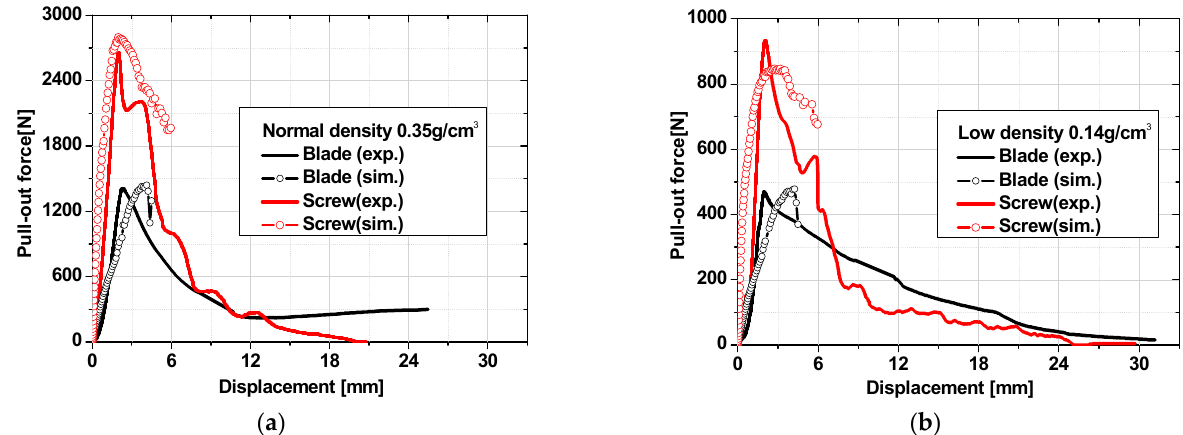
Figure 11. Comparison of pull-out forces between experiment and FEM analysis with screw and helical blade: ( a ) normal density (0.35 g/cm 3 ); ( b ) low density (0.14 g/cm 3 ).